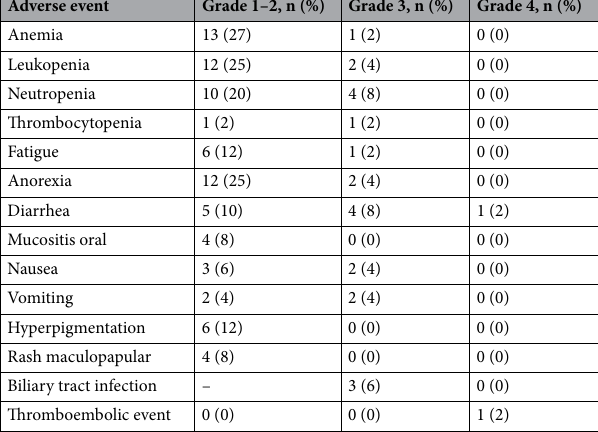
Table 2. Adverse events* related to neoadjuvant S-1 therapy (N = 49). *Events were graded according to Common Terminology Criteria for Adverse Events (CTCAE) version